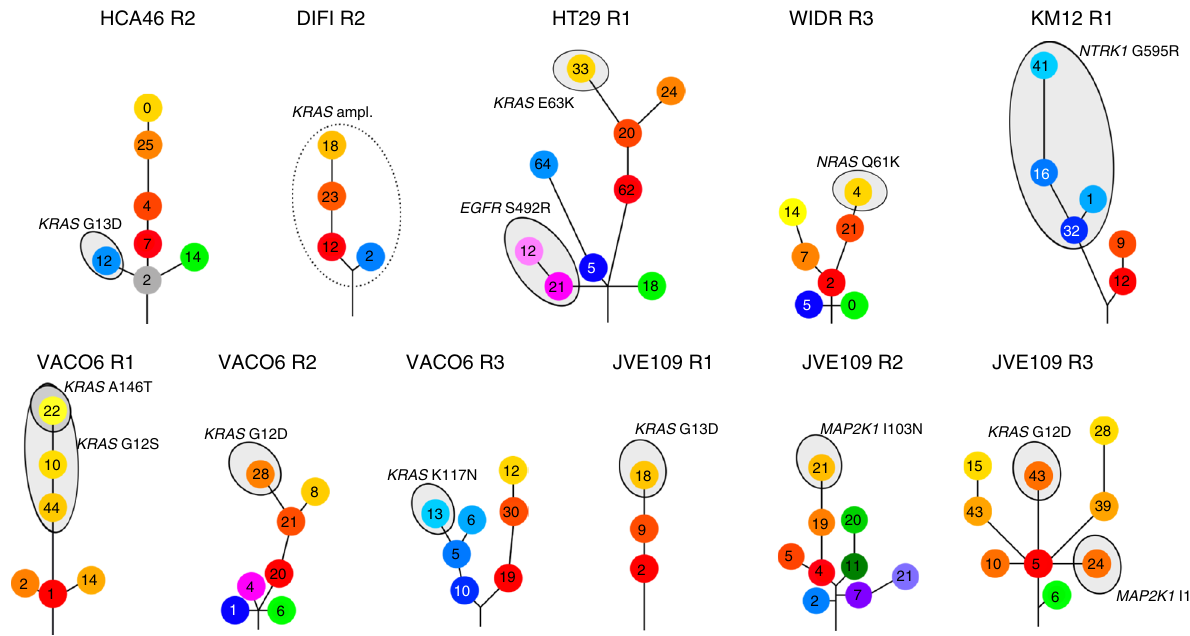
Fig. 2 Clonal evolution of CRC cell populations upon secondary resistance to targeted agents. Phylogenetic evolutionary maps illustrate the development of sub clonal populations after acquisition of secondary resistance to the targeted therapies. The bioinformatic tool EXPANDS was used to infer the clonal architectures using gene copy number, synonymous and non-synonymous somatic mutations, as described in detail in the Material and Methods section. Each circle represents a subclonal population, numbers indicate non-synonymous variations de fi ning clonal sweeps. Length of the branches is proportional to the number of variants (synonymous and non-synonymous) acquired by individual clones, while ancestral branches de fi ne the main colour of its subclones. Subpopulations carrying somatic alterations known to drive drug resistance are highlighted (see Supplementary Table 1). The dashed line indicates KRAS ampli fi